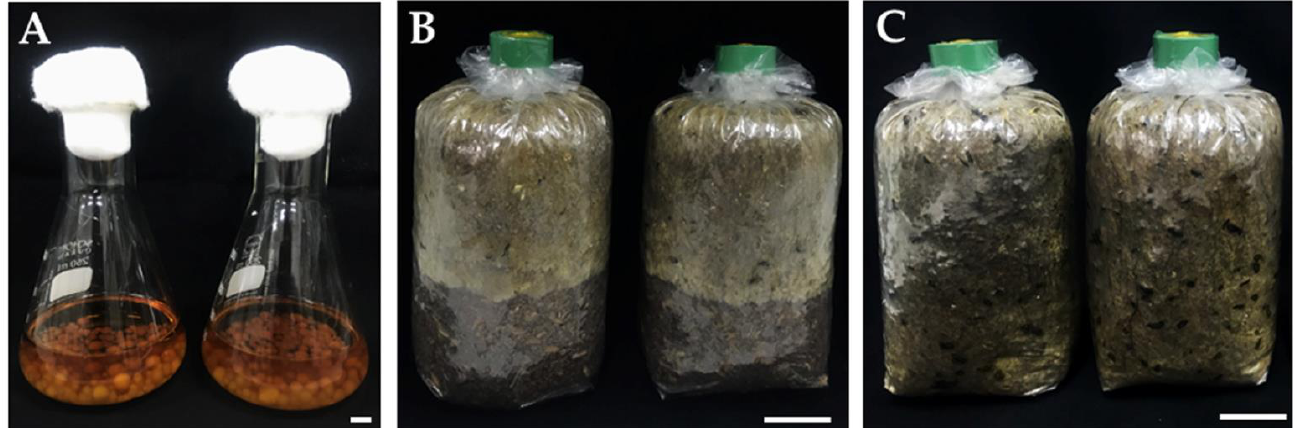
Figure 1. Mycelium liquid inoculum of P . spongiosus SDBR-CMU0517 ( A ) and mycelia grow on substrate after 60 days ( B ) and 90 days ( C ) at 28 ± 2 °C in the dark after inoculation of liquid inoculum. Scale bar A = 1 cm, B and C = 5 cm.